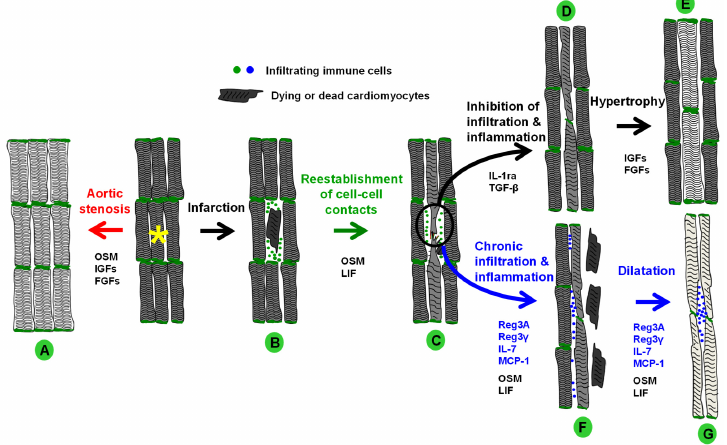
Figure 6. Hypothetical overall model of OSM-driven protection, regeneration, and failure of the heart. ( A ) The development of hypertrophy is initiated by activation of the OSMR in patients with aortic stenosis. When activation of the OSMR cascades decreases, the amount of hypertrophic signals increases (FGFs, IGFs). ( B ) After a cardiac injury such as acute myocardial infarction, OSM- releasing infiltrates reduce damage/infarct expansion and extension by inducing fetal remodeling of cardiomyocytes. Macrophage infiltration is controlled by various chemokine families (Reg3, IL-7, MCPs). ( C ) Cardiomyocytes form extensions and restore cell-cell contacts. ( D ) Infiltration and inflammatory processes are downregulated by anti-inflammatory molecules (IL-1ra, TGF- β ) and hypertrophic pathways are activated (FGFs, IGFs). ( E ) Fetal remodeling is downregulated and myocytes undergo hypertrophic remodeling. Surviving cardiomyocytes adapt to the increased workload by enlarging and accumulating sarcomeres. ( F ) If infiltration and inflammatory processes persist, chronically activated OSM receptors cause degeneration of cardiomyocytes. ( G ) Dying cells and elongation of surviving cardiomyocytes lead to dilatation of the